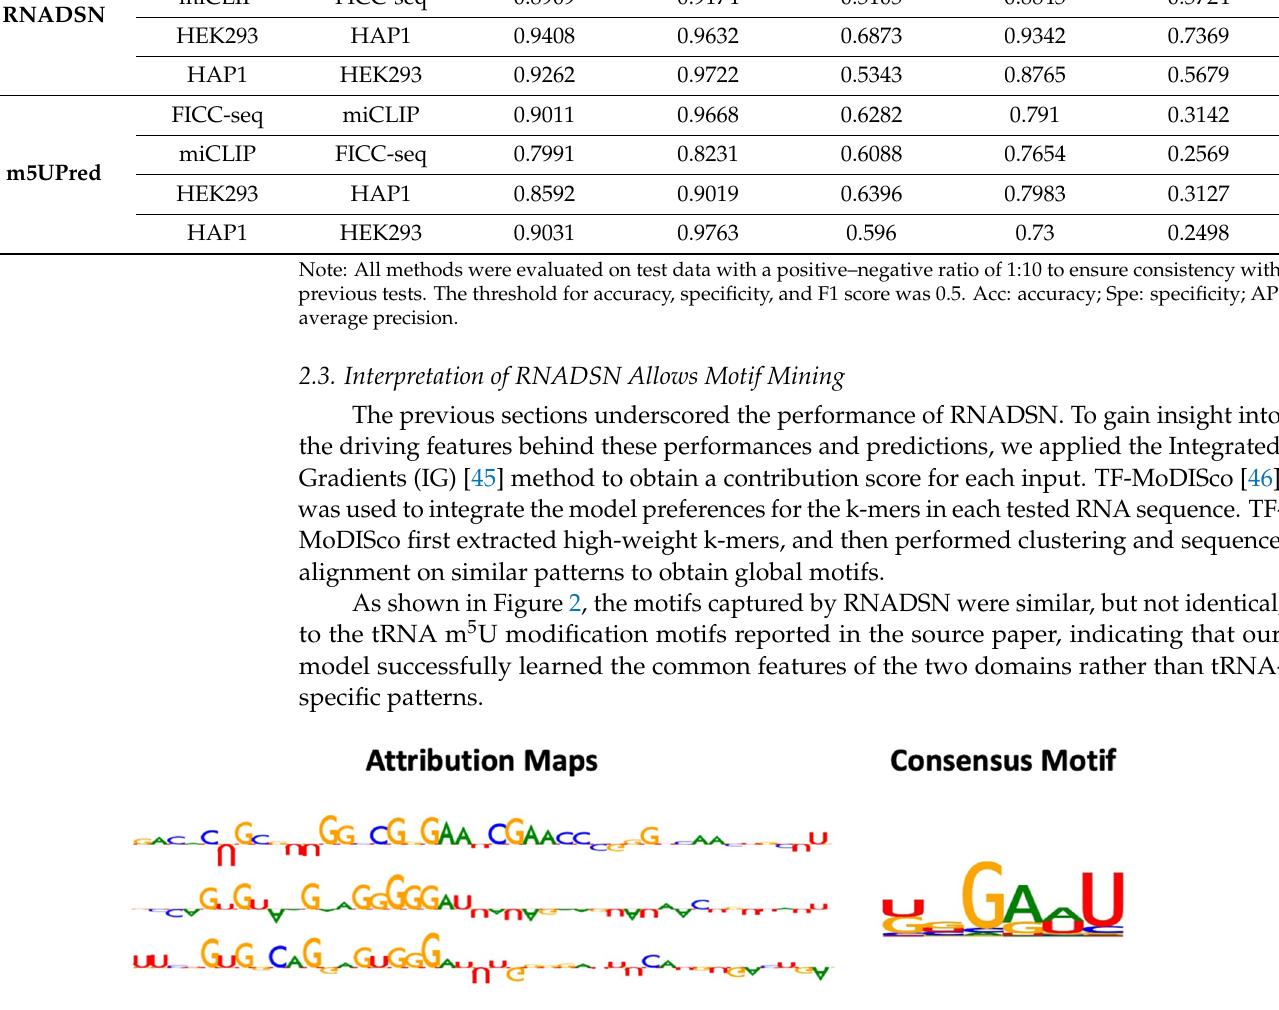
Figure 2. Examples of attribution map and motif detected by RNADSN. In attribution map, upward and downward letters refer to the positive and negative contributions of that nucleotide to the prediction that the central site is a modification. The higher the height, the greater the contribution .